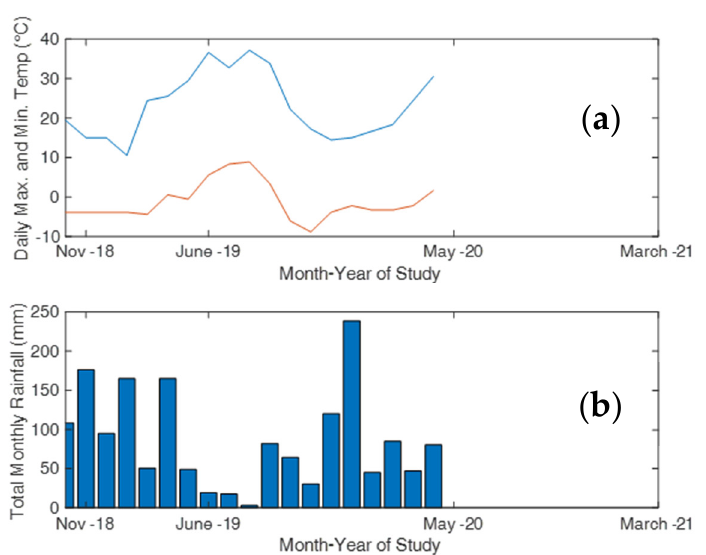
Figure 3. Maximum and minimum temperature and monthly rainfall for the Oregon State University Hyslop Farm during the study. ( a ) mean monthly daily maximum and minimum temperature, ( b ) total monthly rainfall for the site.